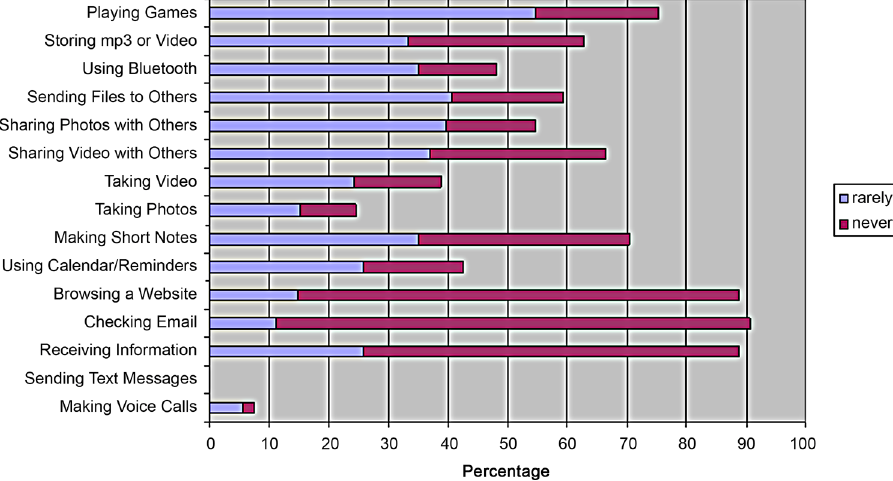
Figure 2. ‘Redundant functionality’ of student-owned mobile